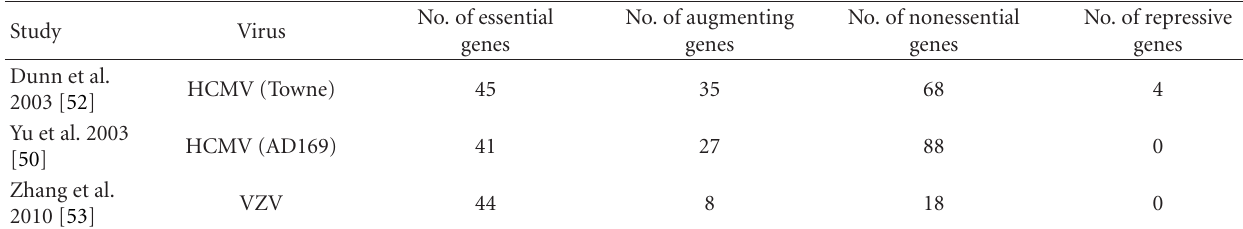
Figure 1: Construction of HCMV BAC . (a) HCMV genome and bacterial plasmid with BAC vector that has been linearized and transfected into human fibroblast cells. (b) BAC vector is inserted into HCMV genome by homologous recombination. The viral genome (now containing the BAC vector) will naturally circularize during replication. (c) HCMV viral BACs are selected based upon expression of a GFP cassette within the BAC vector. (d) Fluorescent plaques are isolated, and viral BAC DNA is extracted. (e) Viral BACs inserted into E. coli cells via electroporation. Successful integration of the BAC vector into the viral genome can be confirmed by (1) selecting colonies with antibiotic resistance resulting in the chloramphenicol-selectable marker in the BAC vector and (2) confirming the BAC genome sequence has not gained any undesired mutations by using restriction digest analysis to compare the BAC DNA to the original viral DNA. (f) If desired, mutagenize the HCMV viral BAC (via site-directed mutagenesis or random transposon mutagenesis). Either way, viral BAC DNA must be isolated via Maxiprep for transfection back into human cells. (g) Transfect BAC DNA into human fibroblast cells in order to produce infectious virus. Table 3: Global studies of human herpesvirus gene